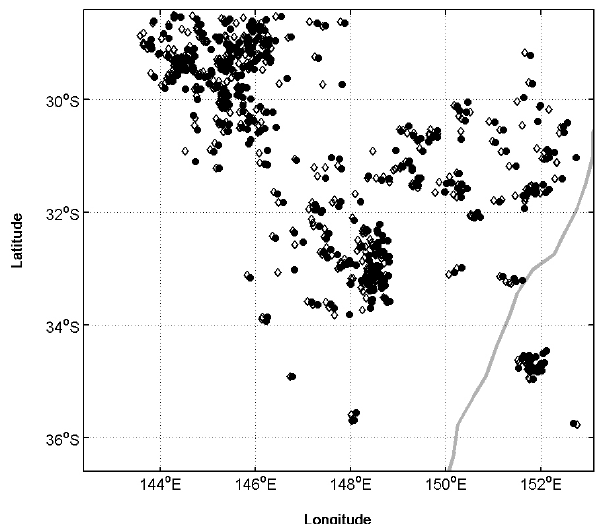
Fig. 6. The positions of the matching lightning events as determined by the Kattron (open diamonds) and WWLL data sets (closed cir- cles). The gray line is part of the east coast of Australia.